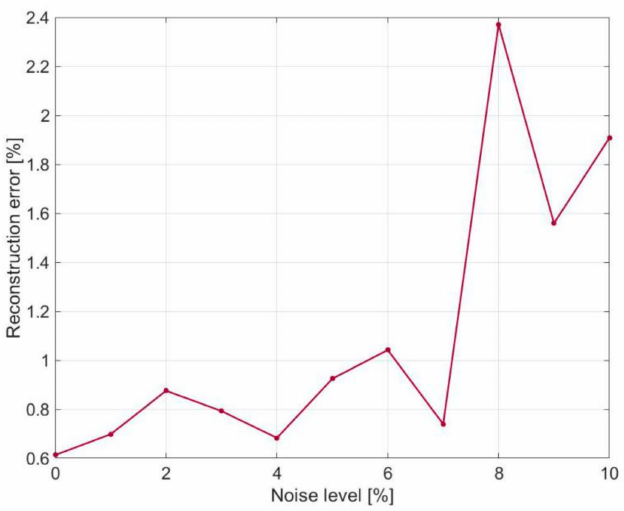
Figure 7. Errors of the reconstructed vibration displacements subject to different levels of noise in strain